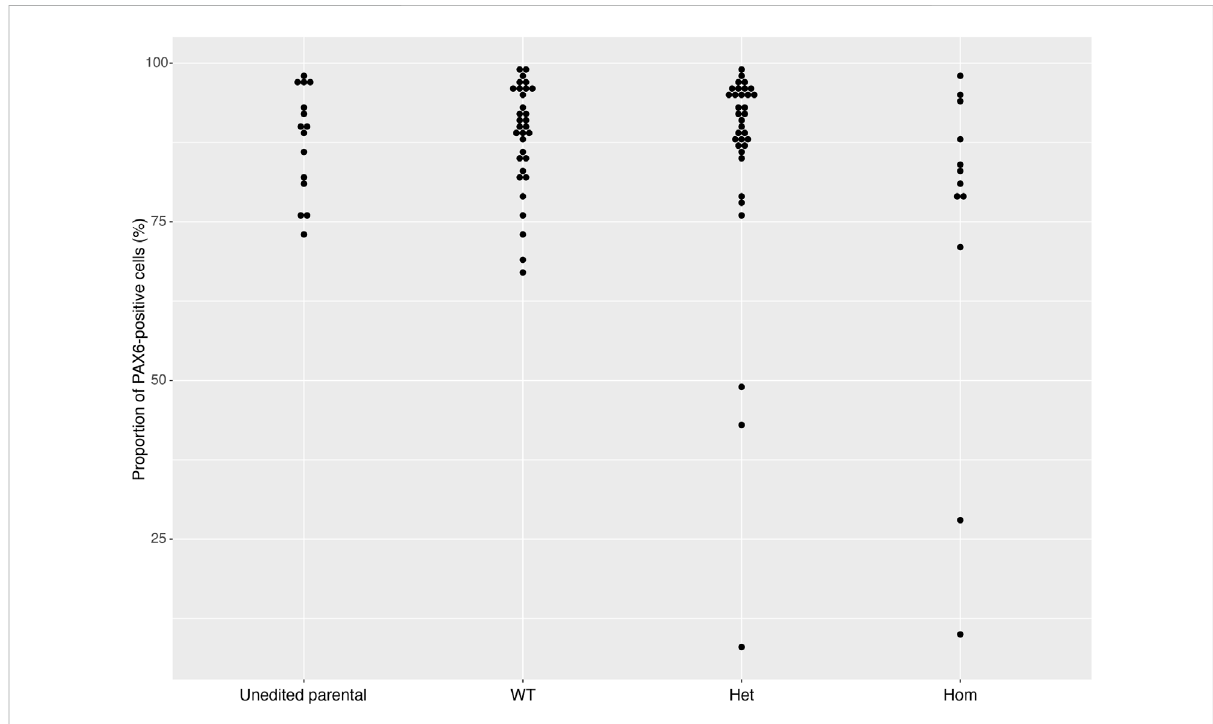
FIGURE 5 PAX6 expression rates across gene sets. The distribution of PAX6 expression rates across 93 cell lines from 16 gene sets successfully differentiated into neural stem cells in 2018 and 2019. Data is separated into Unedited, wild-type (WT), heterozygous (Het) and homozygous (Hom) mutant lines, and shows that the vast majority of cell lines display greater than 80% PAX6-positive cells. Error bars denote ±